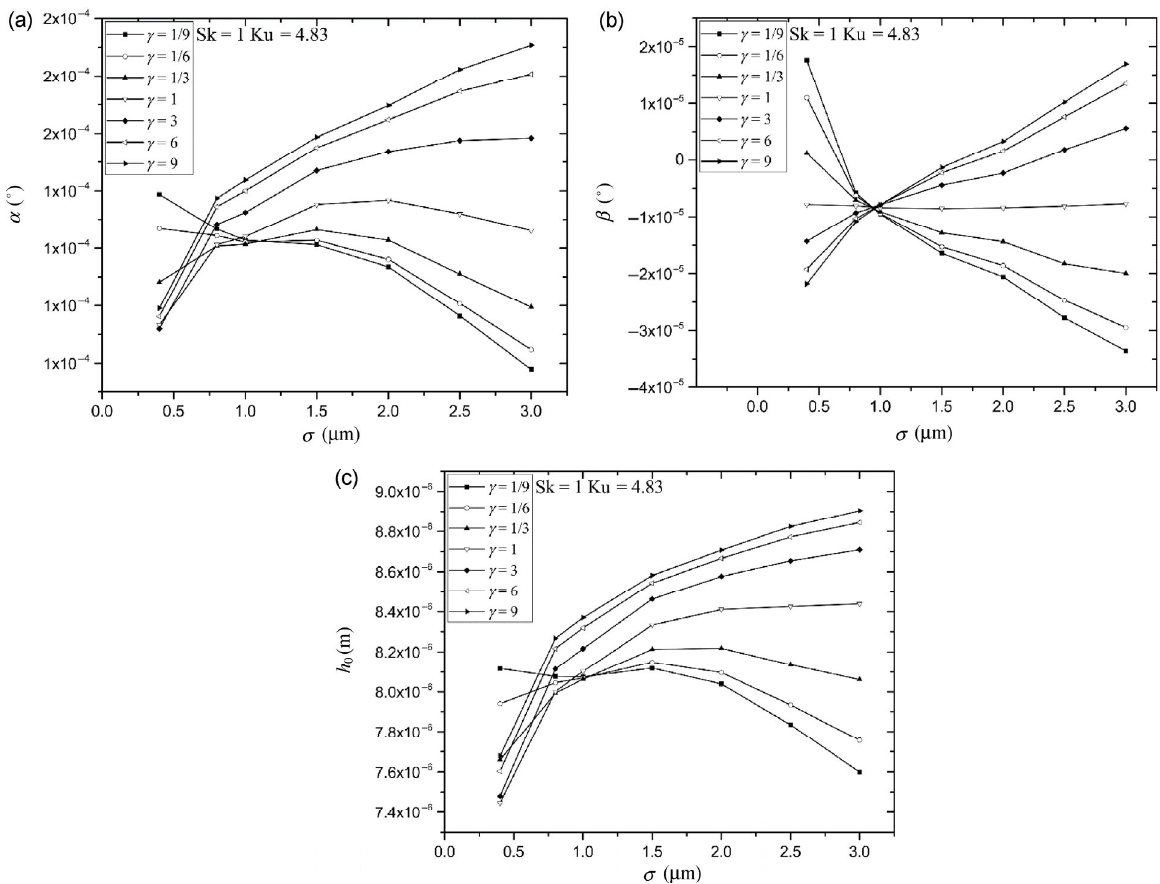
Fig. 9 Tilt angles,  and  and pivot film thickness, h 0 , with various  a  v.s.  b  v.s.  c  h 0  v.s.  Sk = 1, Ku 